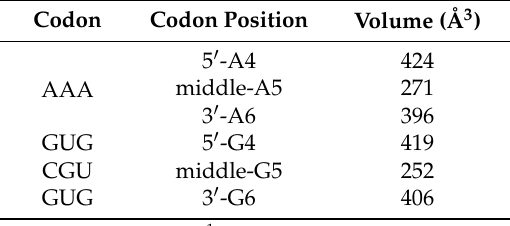
Table 4. Solvent volumes of A-U and G-C base pairs 1 at first elongation